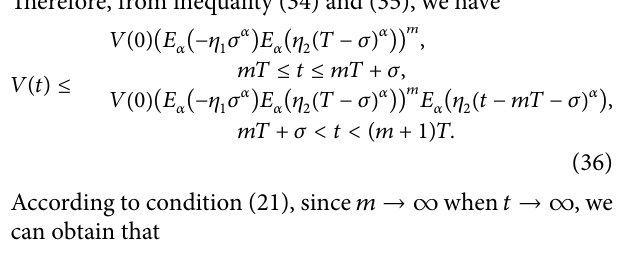
Figure 5: Synchronization errors between systems (13) and (14) with periodic intermittent controller (15), where , , , , and 𝜎 = 0.8 . 𝜂 1 = 30 𝜂 2 = 34 𝑘 = 33 𝑇 = 1